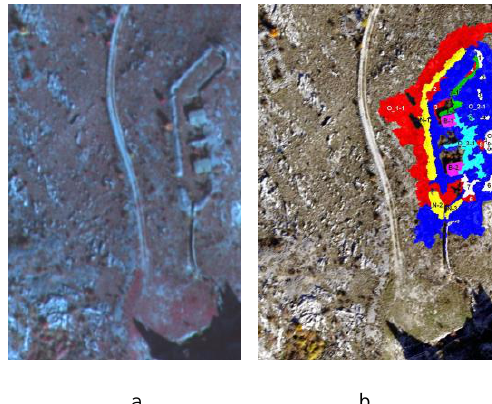
Figure 4. a) The cut part of the colour (RGB) infrared image (VNIR, MS 4100) of the determined position, and b) the presentation with two bunkers (pink), with embankment (yellow), with communication route between them (green) and the surrounding area (red, light and dark blue, and white) on the RGB image (Nikon D90) in the hilly-mountain type of the terrain (ITF, 2010).